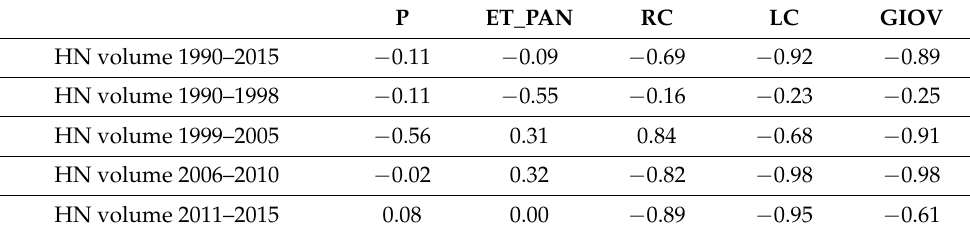
Table 2. The Pearson correlation coefficient between the volume of HN and its driving factors.